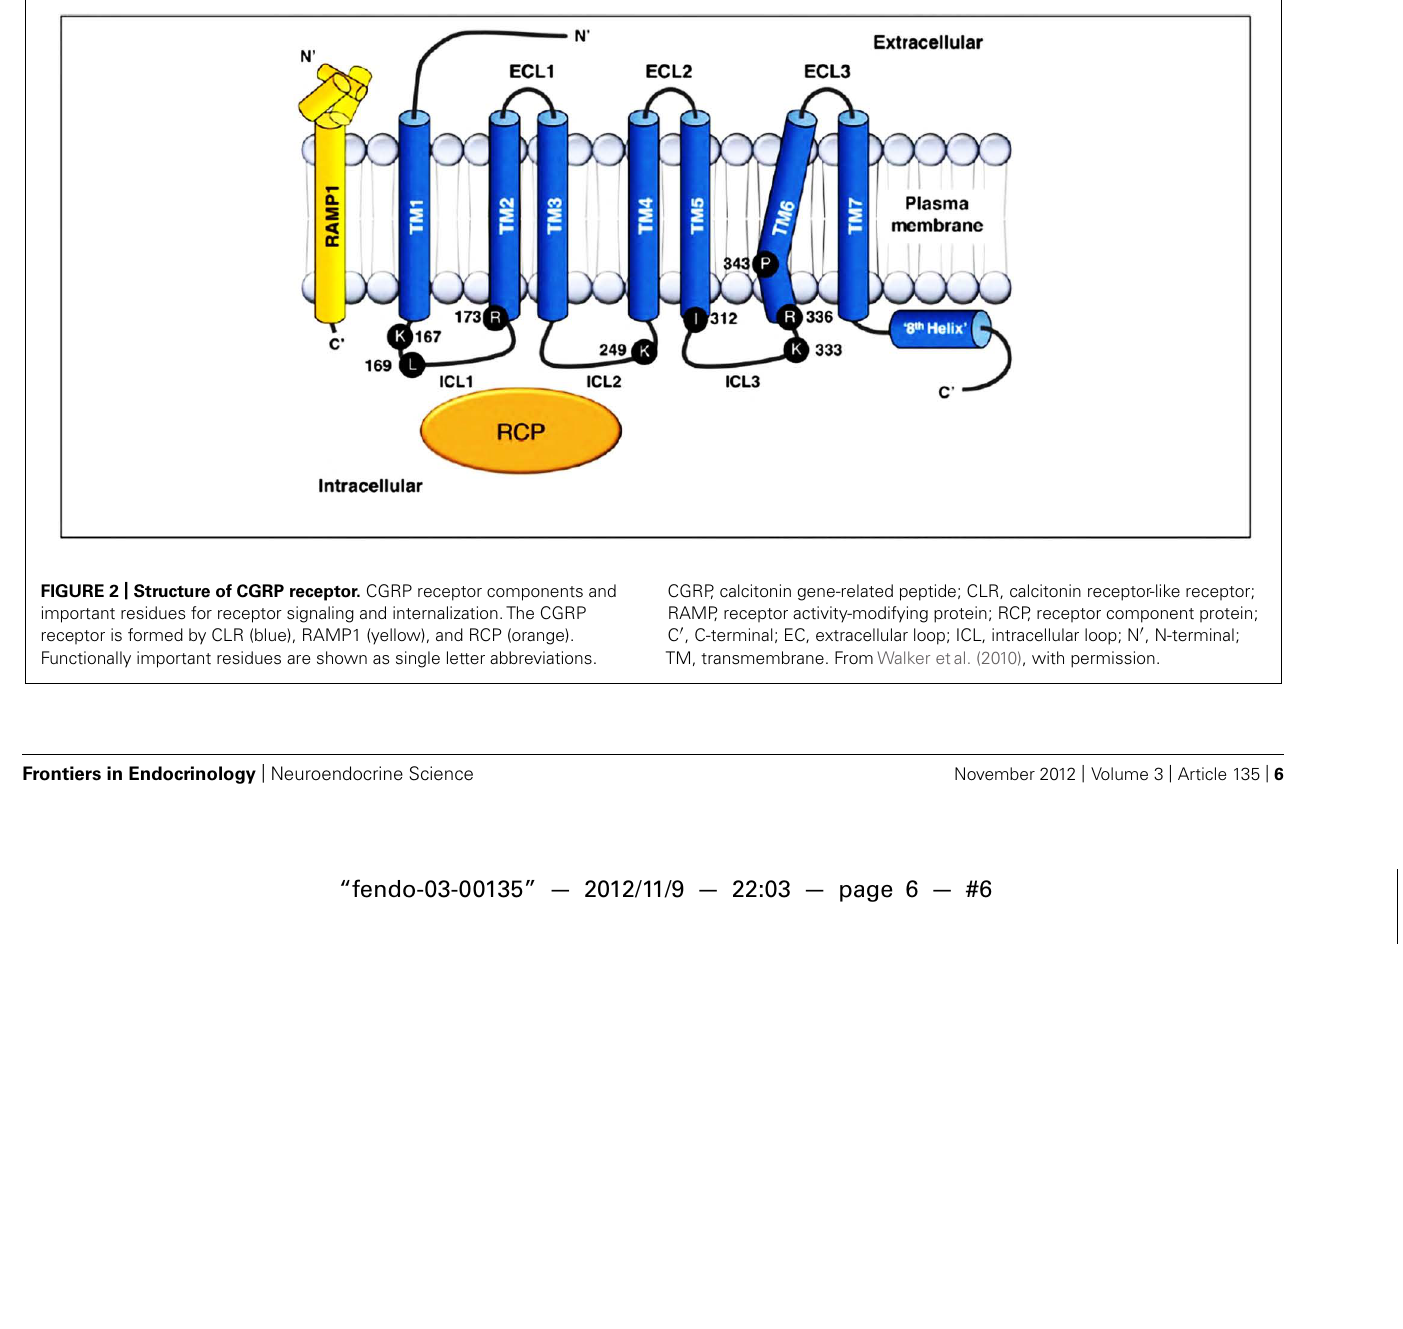
Frontiers in Endocrinology | Neuroendocrine